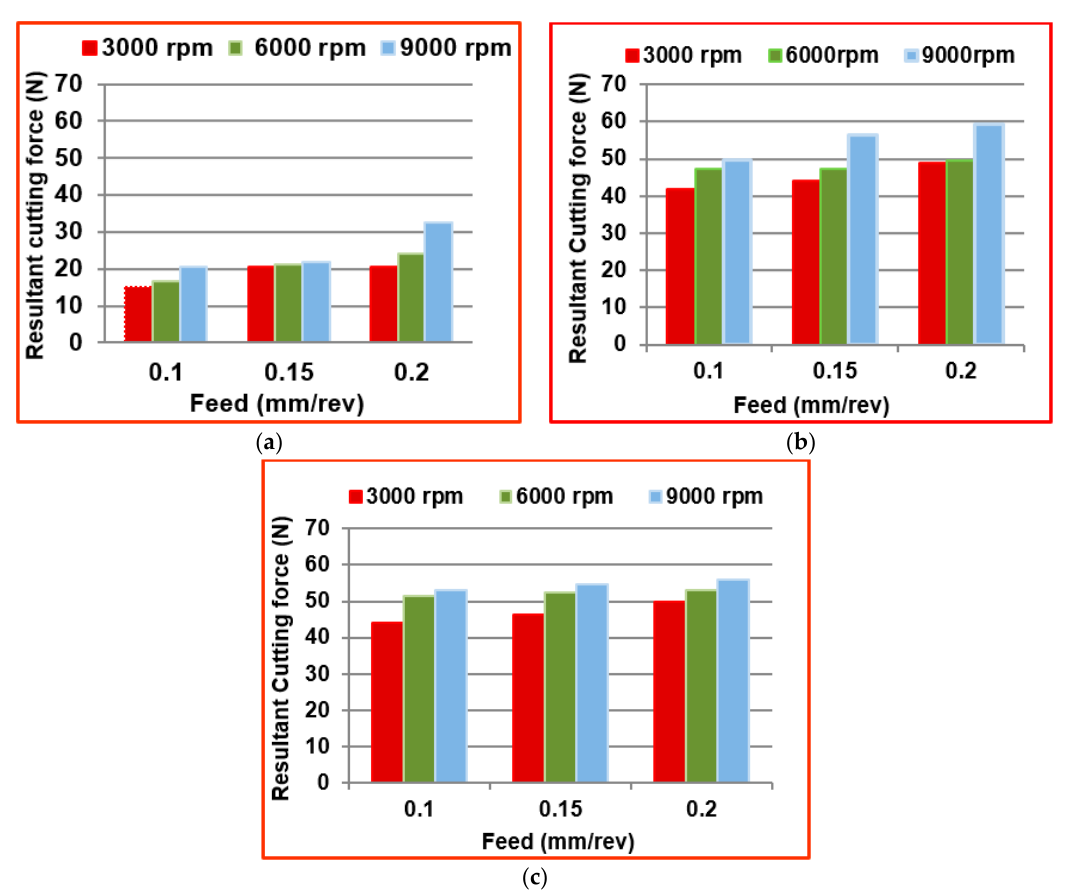
Figure 5. Comparison of resultant cutting forces at different machining conditions with ( a ) Tool T1; ( b ) Tool T2; and ( c ) Tool T3.